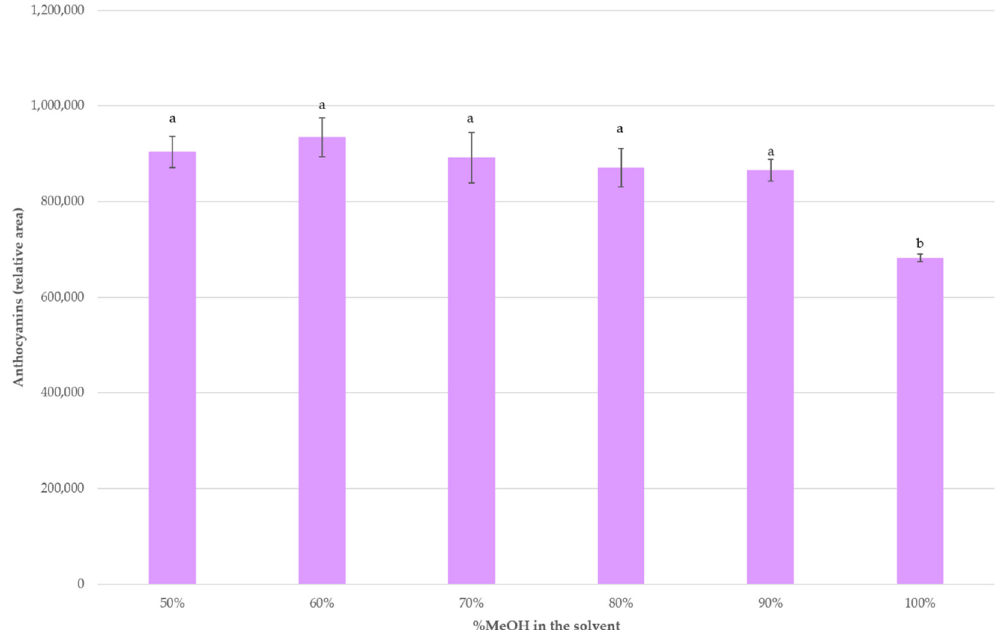
Figure 4. Average anthocyanins recoveries ( n = 3) with different solvent percentages. A different letter over a bar indicates a significant difference ( p -value < 0.05).